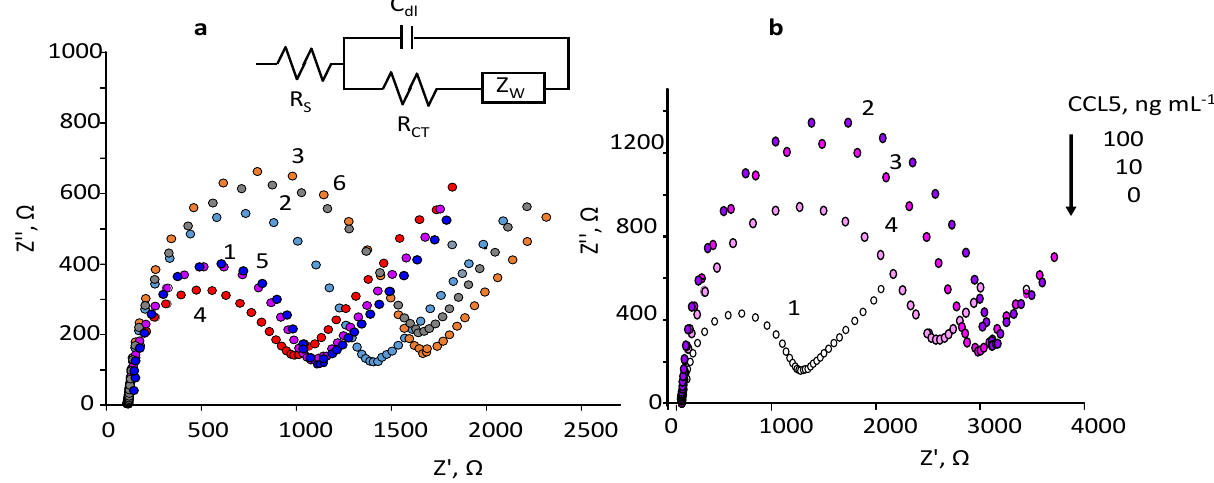
Figure 3. mM Fe(CN) 63 − /4 − in 0.1 M PB of pH 7.4 for: ( a ) bare SPCE (dark blue,1); Neu–MBs/SPCE (light blue, 2); anti–CCL5–Biotin–Neu-MBs/SPCE (yellow, 3); CCL5–anti–CCL5–Biotin–Neu–MBs/SPCE (red, 4); anti–CCL5–CCL5–anti–CCL5–Biotin–Neu–MBs/SPCE (purple, 5); HRP–IgG– CCL5–anti–CCL5–Biotin–Neu–MBs/SPCE (grey, 6). The equivalent circuit used to adjust the ex- perimental results is also shown; ( b ) bare SPCE (white, 1); HRP–IgG–CCL5–anti–CCL5–Biotin– Neu–MBs/SPCE for 100 (violet, 2) 10 (purple, 3) and 0 (pink, 4) ng·mL − 1 CCL5.